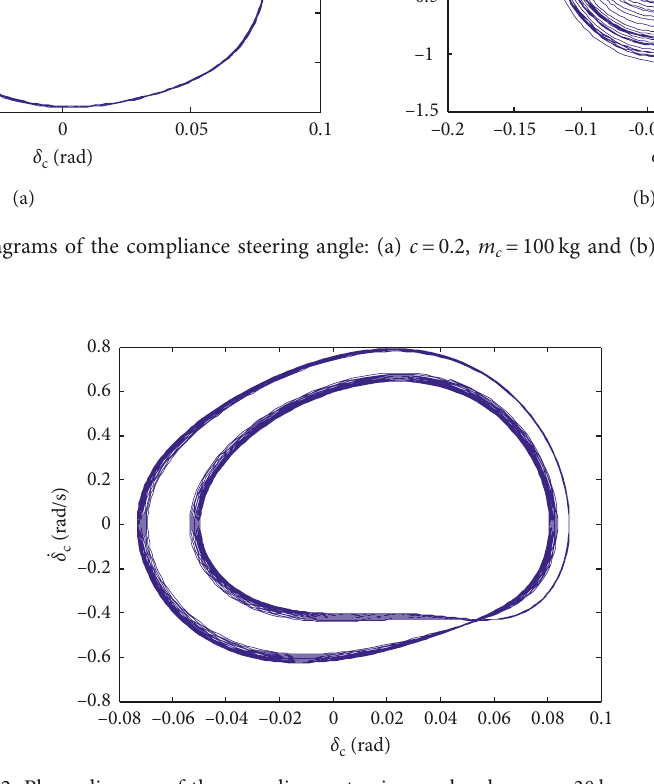
c (cid:30) 30kg and c (cid:30) 0.2.